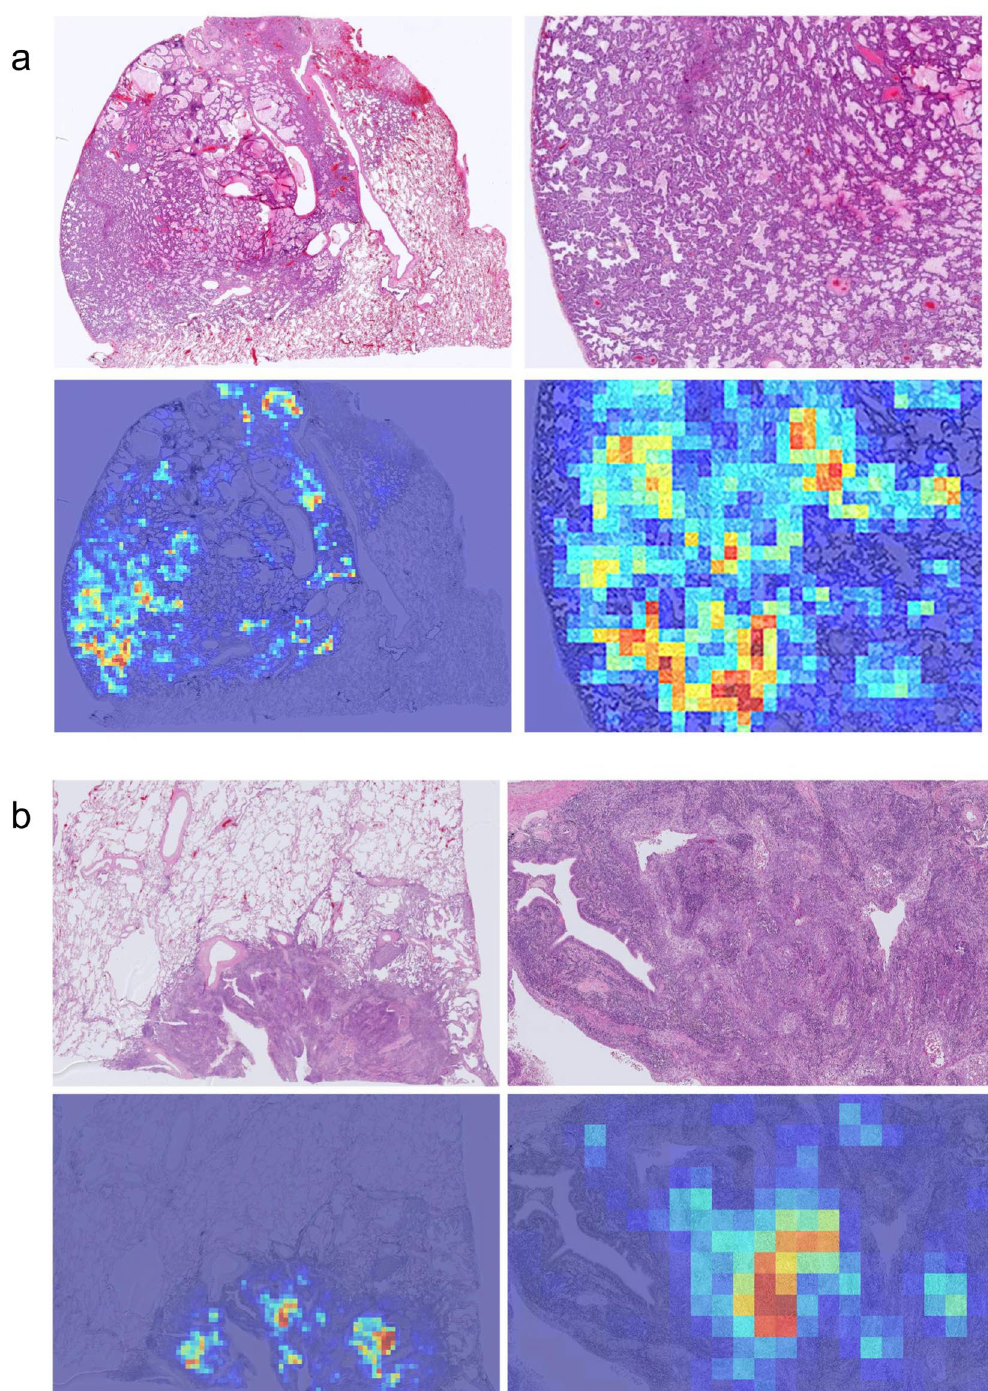
Figure 3. Example heatmap outputs for carcinoma prediction using the weakly-supervised method on ( a ) adenocarcinoma and ( b ) squamous cell carcinoma. A stride of 256 × 256 was used on a magnification of